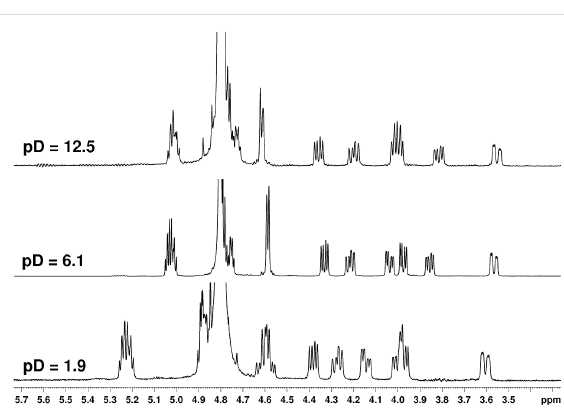
Figure 6: The deuteration equilibria of phosphonomethyl derivatives 7–10 .